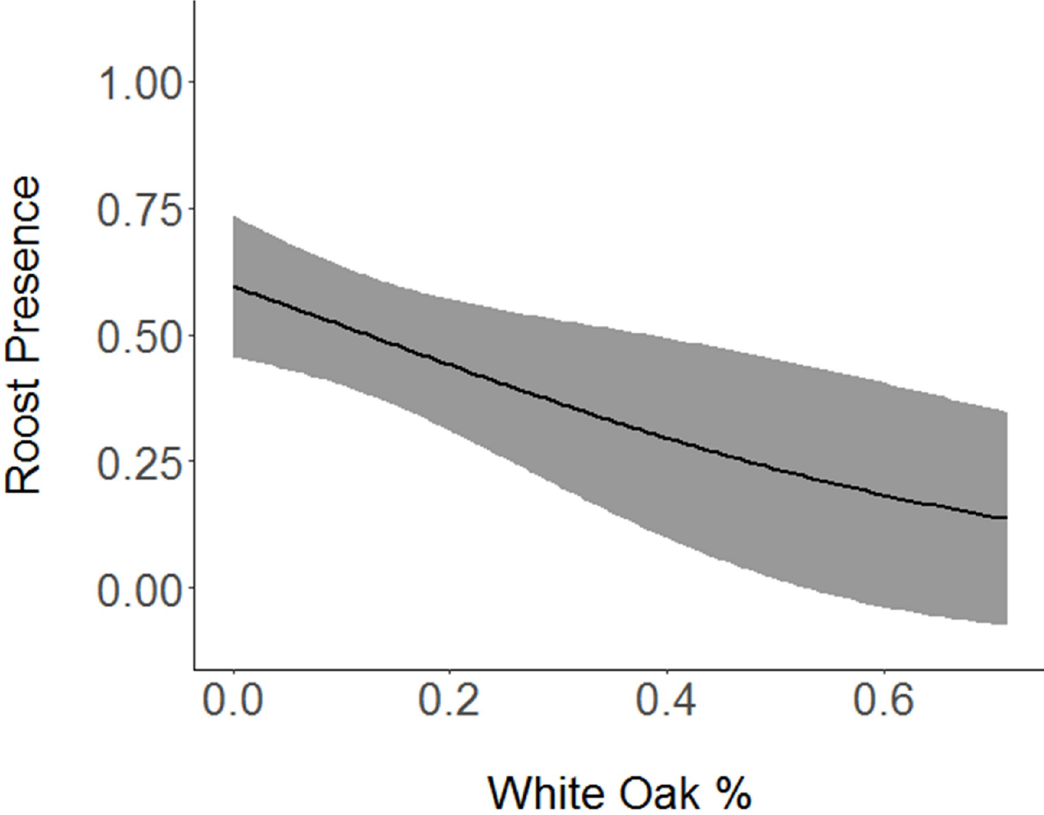
Fig 3. Association between Cerulean Warbler roosts and white oak. Cerulean Warbler ( Setophaga cerulea , Wilson) roost sites were negatively associated with increased white oak ( Quercus alba ) abundance at Morgan-Monroe and Yellowwood state forests in southern Indiana, 2017. The gray area represents 95% confidence intervals. Original data are on the x-axis.